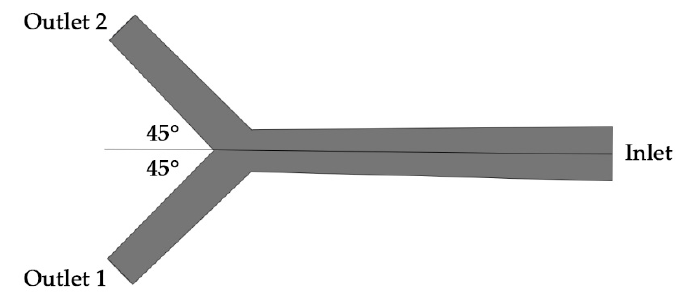
Figure 3. Hepatic artery bifurcation model for numerical simulations.